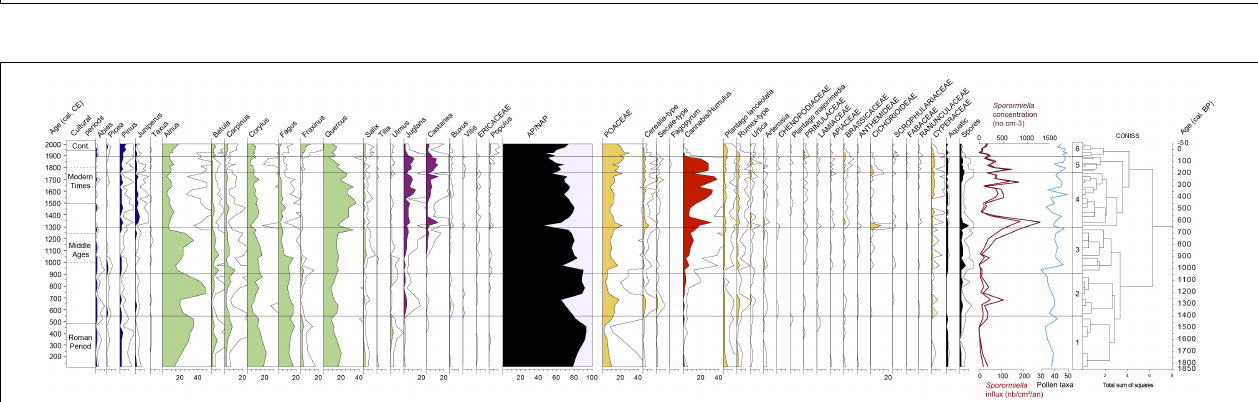
FIGURE 5 | Temporal trajectory of plant composition as revealed by a non-metric multidimensional scaling (NMDS) analysis from pollen data (stress value = 0.14). (A) Sample distribution in the NMDS plot. The color code represents the different cultural periods. (B) Distribution of arboreal pollen taxa (AP) and taxa related (or potentially related to) human activities in the NMDS plot. (C) Distribution of all other taxa in the NMDS plot.